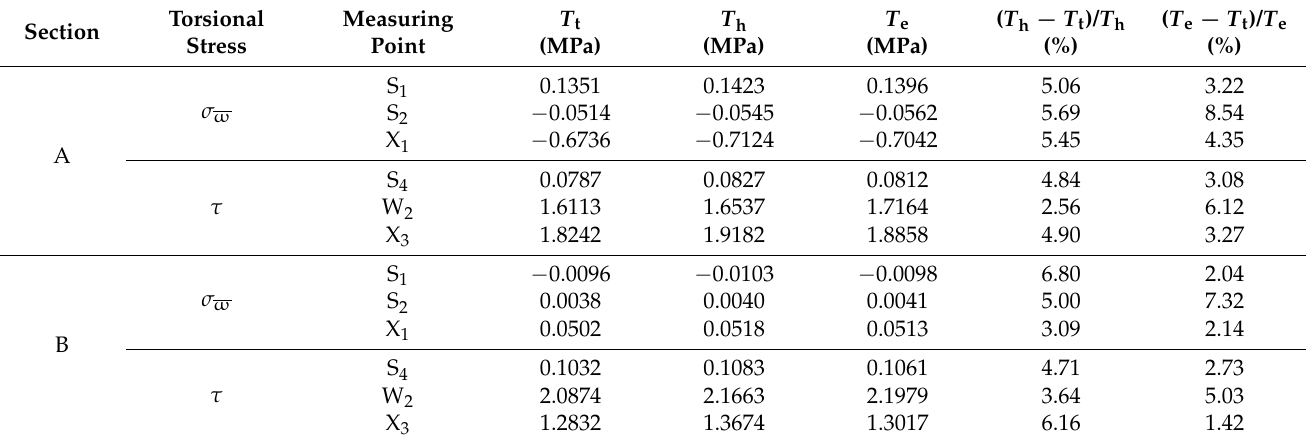
Table 1. Torsional stress comparison.